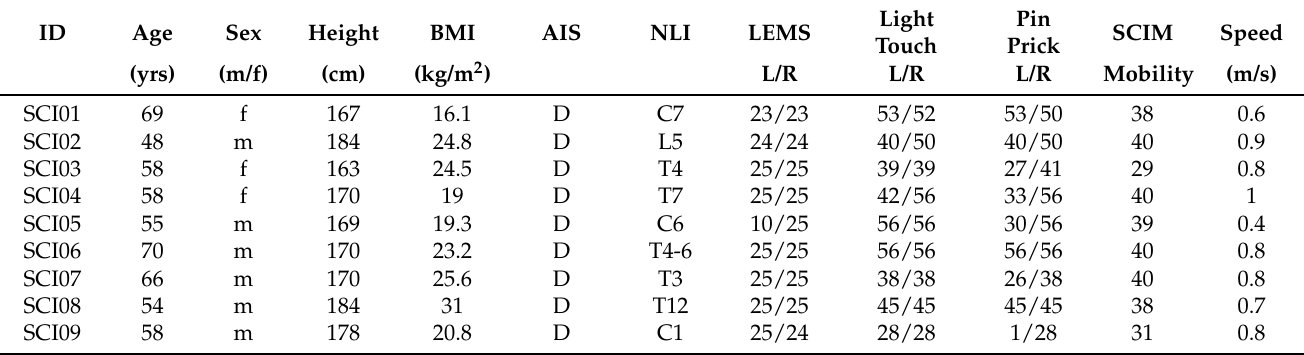
Table 1. Demographics (age, sex, height, and BMI) and clinical scores are listed of the spinal cord injury (SCI) patients who participated in the study. Within clinical scores, the completeness of injury (AIS), neurological level of injury (NLI), lower extremity motor score (LEMS), light touch, pin prick, and the mobility sub-score of the spinal cord independence measure (SCIM) are reported. The preferred walking speed as determined during the measurement is given for each